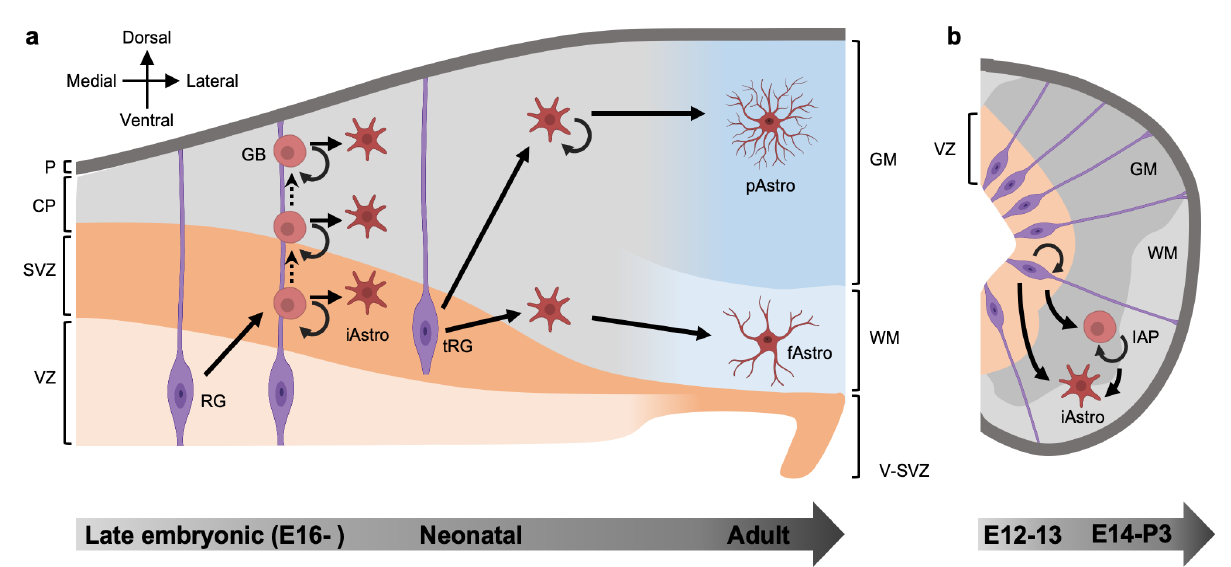
Figure 2. Astrocytogenesis from the ventricular/subventricular zones and outer cortical layers in the mouse developing central nervous system (CNS). ( a ) In the developing cortex, radial glia (RG) first give rise to glioblasts (GBs) during the late embryonic to perinatal period. Glioblasts undergo several rounds of division while migrating out along radial glia, resulting in clusters of astrocytes in the developing cortex. At the terminal stage of radial glial differentiation, radial glia detach from the ventricular zone and form unipolar transitional radial glia (tRG), which give rise to protoplasmic and fibrous astrocytes in the gray matter and white matter of the cortex, respectively. During the early postnatal period, differentiated astrocytes in the outer cortical layer undergo symmetric division and generate daughter astrocytes that exhibit astrocytic morphology and functions. ( b ) In the developing spinal cord, radial glia first proliferate during embryonic day 12 (E12) to 13, giving rise to radial glial pool which differentiates into astrocytes between E14 and postnatal day 3 (P3). Alternatively, radial glial cells differentiate into intermediate astrocyte precursors (IAPs), which proliferate during E14 to P3 and undergo terminal differentiation, ultimately giving rise to astrocytes. The progression from embryonic stage to adult is shown from left to right below each panel. Straight arrows indicate differentiation or maturation from one cell type to another. Circular arrows indicate proliferation. Dashed arrows indicate migration. CP, cortical plate; fAstro, fibrous astrocyte; GM, gray matter; iAstro, immature astrocyte; P, pia mater; pAstro, protoplasmic astrocyte; SVZ, subventricular zone; VZ, ventricular zone; WM, white